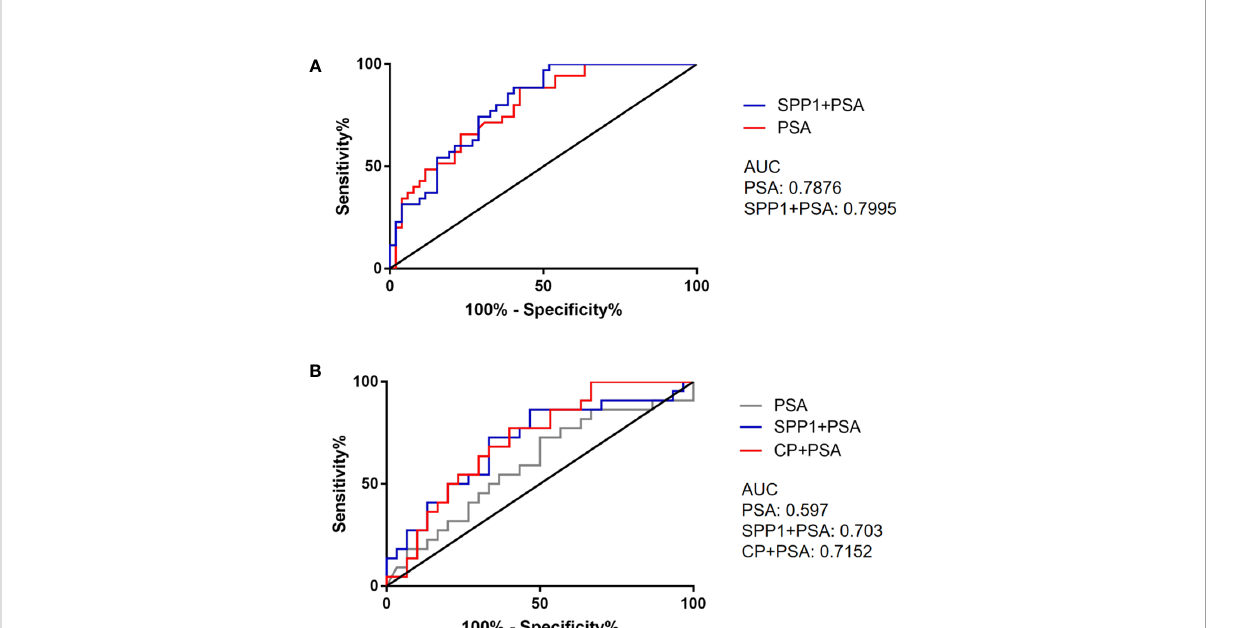
FIGURE 7 ROC curves of selected biomarkers. (A) ROC curves of PSA and combined detection of SPP1 in separating PCa and BPH. (B) ROC curves of PSA and combined detection of SPP1, CP in separating AG and